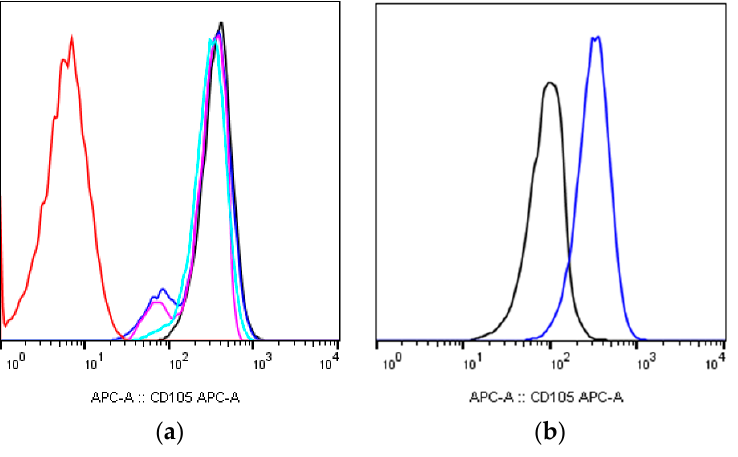
Figure 2. The CD105 expression level one of the donors MSCs 16 days after irradiation at dose of 50 mGy: ( а ) histogram of unstained control (red), stained non-irradiated control (black), and CD105 dim and CD105 + populations of stained irradiated MSCs from 3 donors, n = 3 (pink, blue, and light blue); ( b ) histogram of difference in fluorescence between CD90 + /CD105 dim (black) and CD90 + /CD105 + populations (blue).